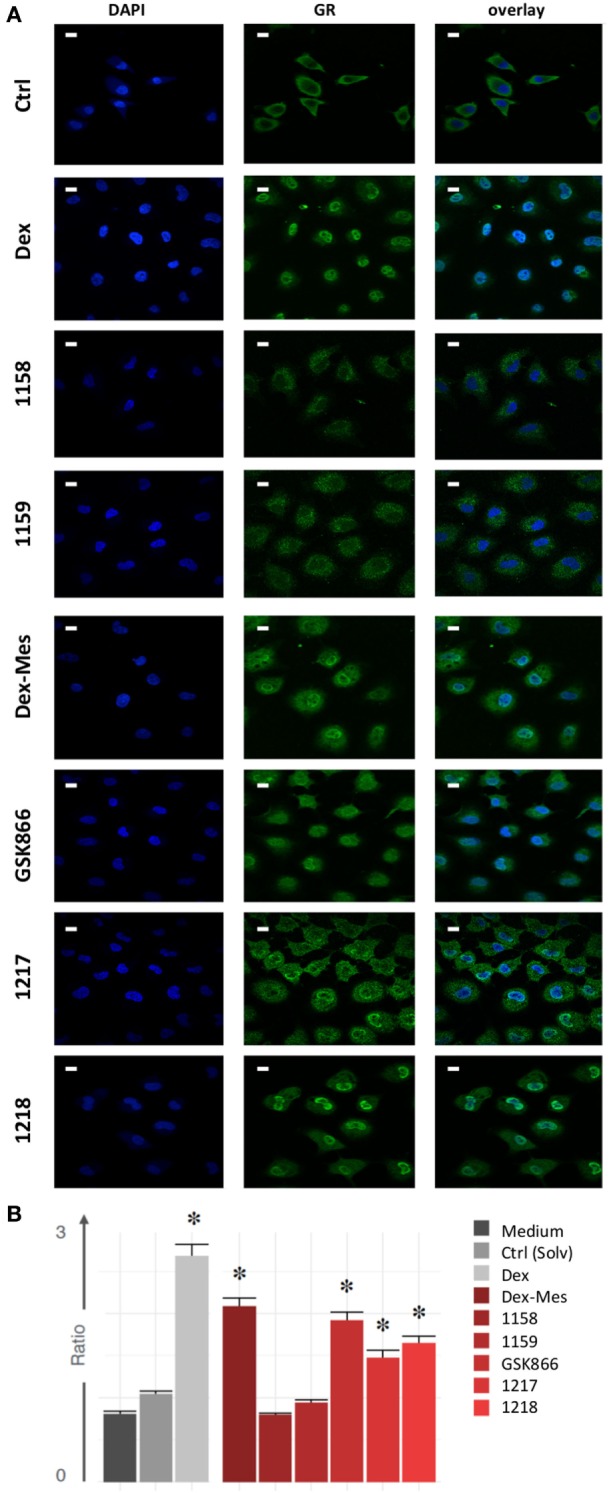
Selective glucocorticoid receptor agonist GSK866 analogs UAMC-1217, UAMC-1218, but not UAMC-1158 and UAMC-1159 trigger nuclear glucocorticoid receptor (GR) translocation. (A) Serum starved A549 cells were left solvent treated or treated for 30 min with 1 µM Dex, Dex-mesylate (Dex-Mes), GSK866, UAMC-1158, UAMC-1159, UAMC-1217, or UAMC-1218. GR translocation was evaluated by immunofluorescence whereas nuclei were stained by DAPI dye. Magnification is at 100×. White scalebars represent 20 µM. (B) Automated image quantification of GR translocation of three replicate immunofluorescence images of the different experimental setups.